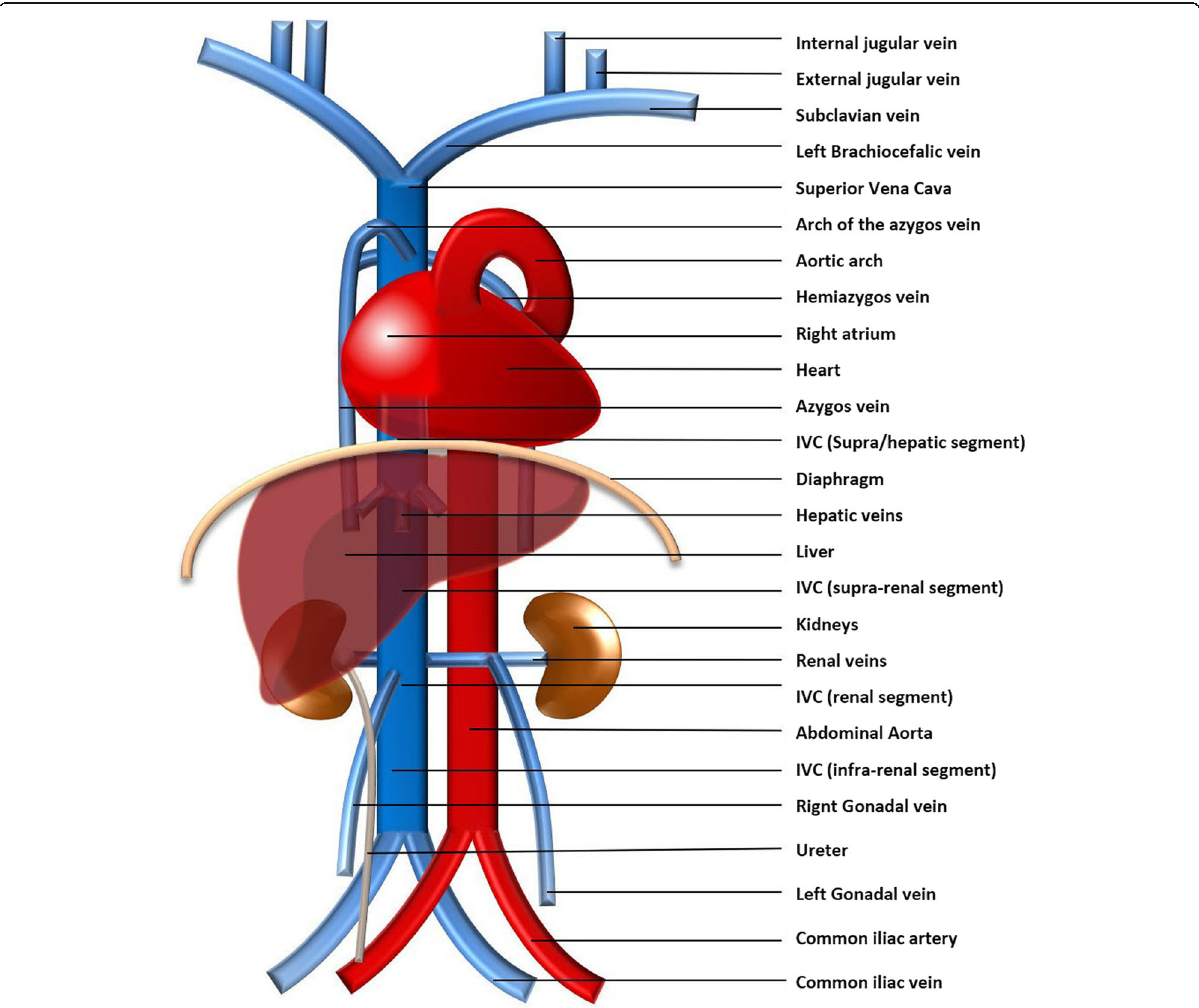
Fig. 1 Normal systemic venous system schematic. The typical systemic venous system consisting of the right-sided superior vena cava, result of the confluence of the brachiocephalic veins, and the right-sided inferior vena cava (IVC), formed by the confluence of the common iliac veins, which respectively, drain the venous blood from the upper and lower body to the right atrium. Due to its particular embryology and relationship with the abdominal organs, the IVC can be subdivided in different segments (suprahepatic, hepatic, suprarenal, renal, infrarenal segments) and is asymmetric, with the gonadal and suprarenal veins draining directly into it on the right but to the left renal vein, instead, on the left. The azygos- hemiazygos venous system, running on the side of the vertebral column, drains the thoracic wall and superior lumbar region into the